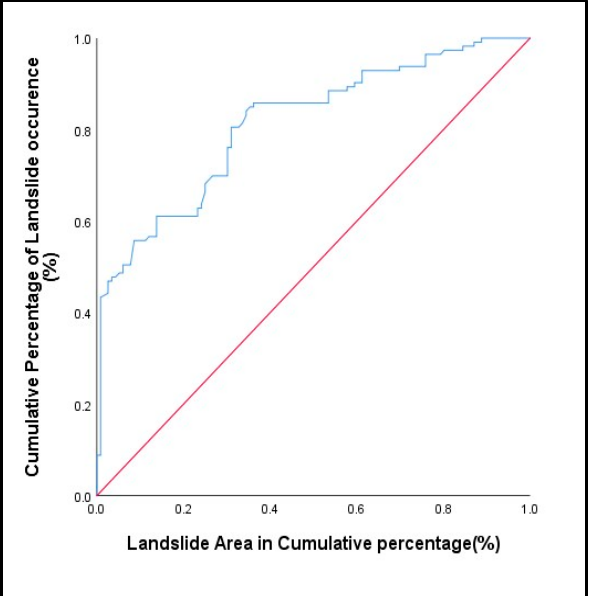
Figure 7. Accuracy of the model represented in a success rate curve.